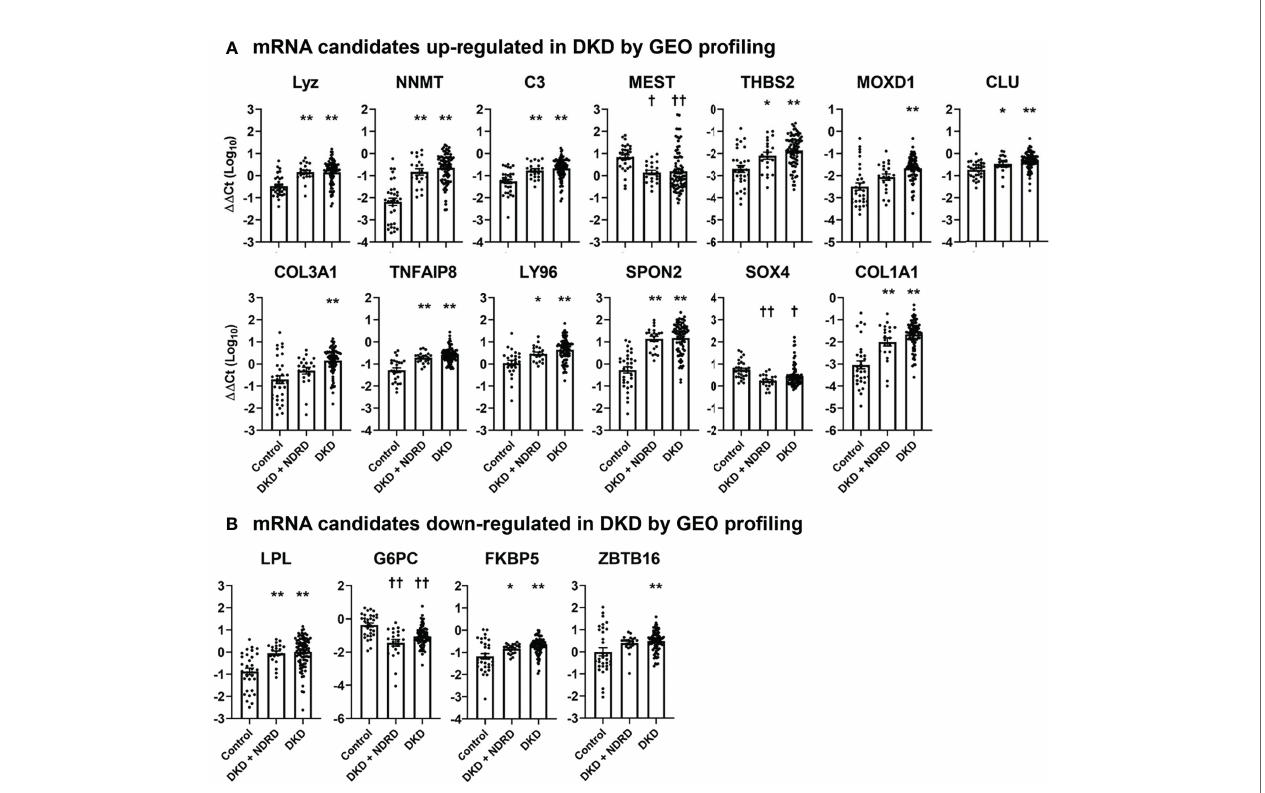
FIGURE 2 | Urinary levels of diabetic kidney disease-speci fi c mRNA candidates in healthy controls, patients with combined diabetic kidney disease and non-diabetic renal disease, and those with isolated diabetic kidney disease. The levels of selected mRNA biomarker candidates whose expressions are signi fi cantly altered between the different groups are shown. (A, B) mRNA candidates up-regulated (A) and down-regulated (B) in DKD via GEO pro fi ling. mRNA levels are measured by quantitative real-time polymerase chain reaction and are expressed as log-transformed delta-delta cycle threshold ( DD Ct) after an adjustment by 18S rRNA and controls. Five mRNAs among those listed in ( CX3CR1, HOPX, COMP, APOLD1 , and CYP27B ) are not illustrated in this fi gure as these mRNAs failed to pass the quality control process. * p < 0.05, ** p < 0.005, up-regulated vs . control; † p < 0.05, †† p < 0.005, down-regulated vs . control. DKD, diabetic kidney diseases; NDRD, non-diabetic renal disease; GEO, gene expression